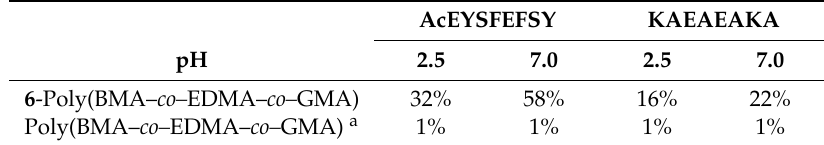
Table 2. Interaction of unmodified and modified poly(BMA– co –EDMA– co –GMA) with peptides, using calix[4]resorcinarene 6